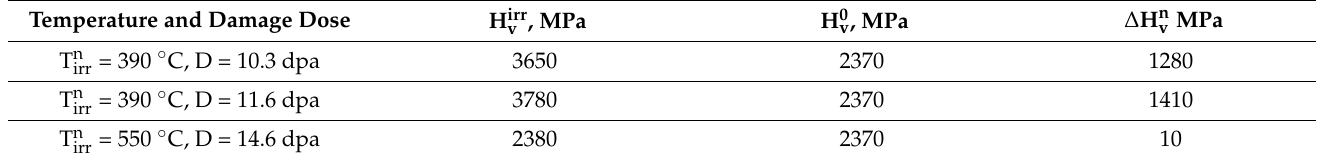
Table 8. Conditions of neutron irradiation (T n , D), hardness values in the initial, H 0 v , and irradiated, irr H irr v , states and increment of hardness due to irradiation, ∆ H n v , of 12Cr F/M